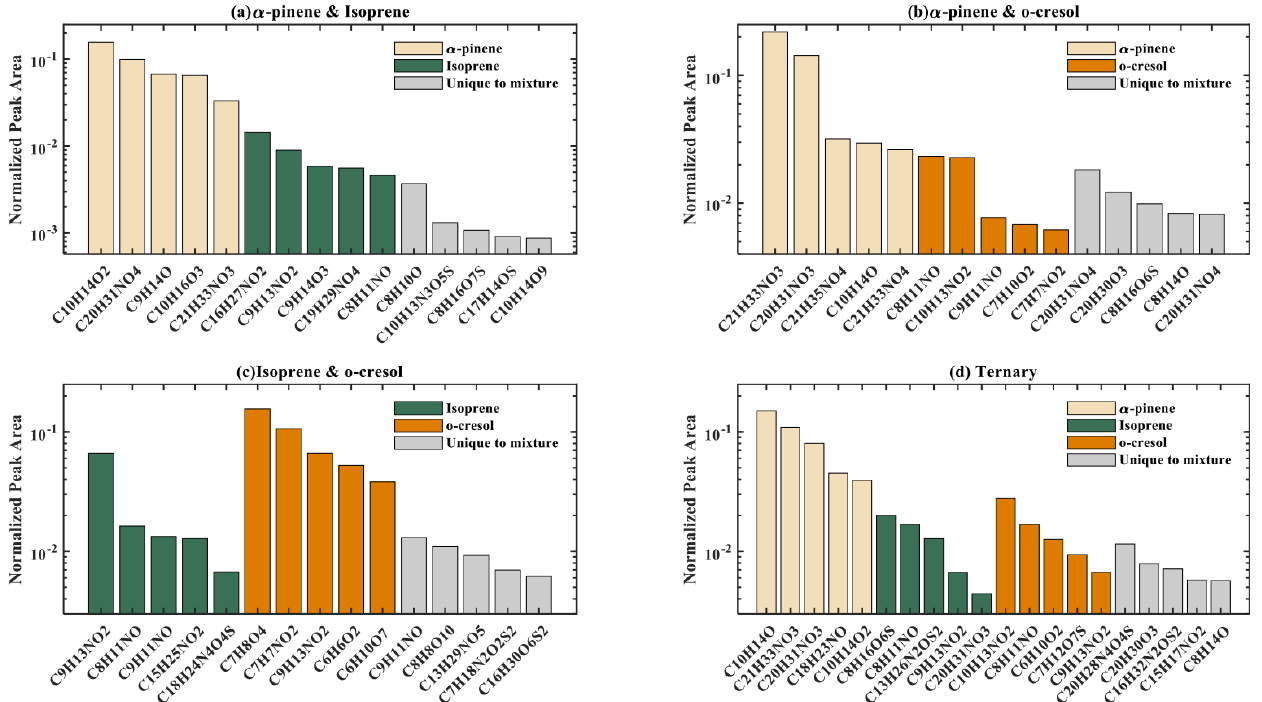
Figure 7. The dominant compounds in terms of their normalized peak area in the mixed VOC systems shown in the bars: (a) binary α - pinene–isoprene system, (b) binary α -pinene– o -cresol, (c) binary isoprene– o -cresol, (d) ternary system. The normalized peak areas of these selected compounds in a mixed precursor system are also presented if they existed in the corresponding single precursor system (yellow: single α -pinene, green: isoprene, orange: o -cresol). The compounds are considered identical in the mixed system and single VOC systems if they have the same empirical formula and a retention time difference of < 0.1min in positive ionization